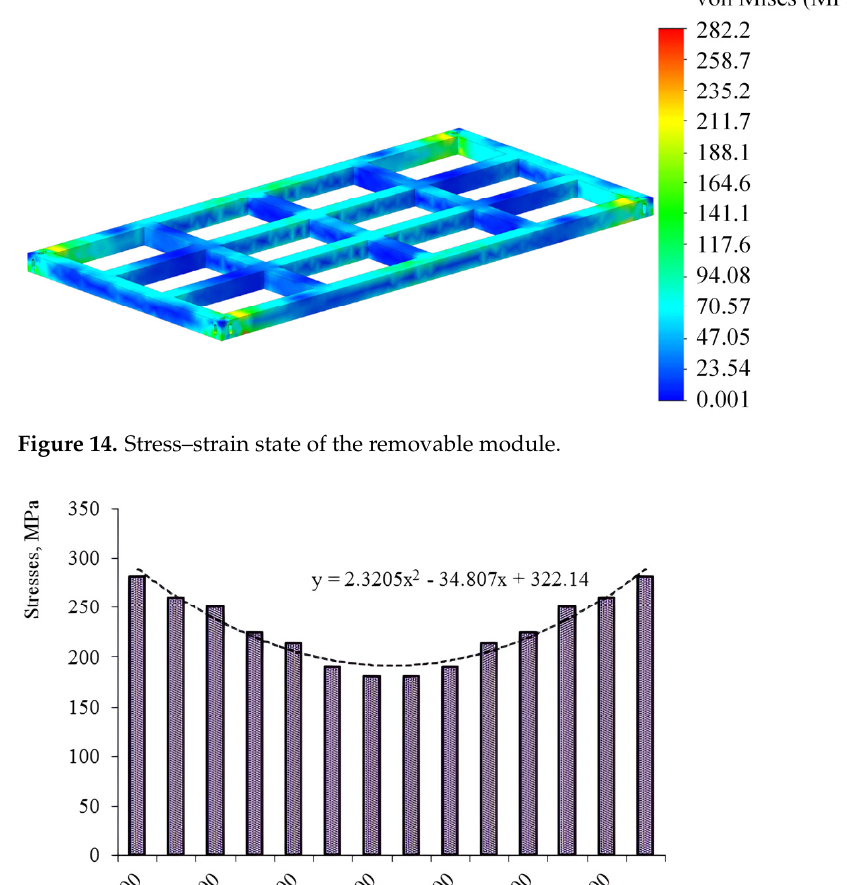
Figure 15. Distribution of the stresses along the side beam of the removable module (l is the length of the removable module).